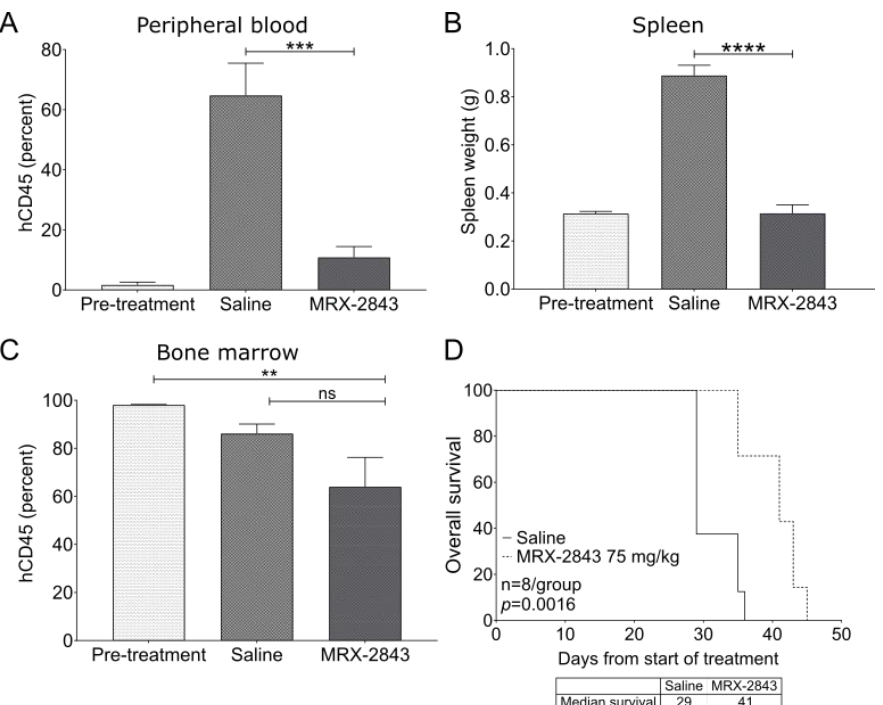
Figure 6. MRX-2843 monotherapy promotes leukemia clearance in peripheral blood and spleen, and prolongs survival in a patient-derived ETP-ALL xenograft model. ( A – D ) NSGS mice were inoculated with xenograft-passaged cells from a patient with ETP-ALL (ETP0068TJ) and treatment was initiated 36 days later. ( A – D ) A cohort of mice were harvested prior to the start of treatment (pre-treatment). The remaining mice were treated once daily with 75 mg/kg MRX-2843 or saline vehicle. ( A – C ) After treatment for 29 days, peripheral blood ( A ), spleen ( B ), and bone marrow ( C ) were collected and leukemic blasts (hCD45+) were detected by flow cytometry. Spleen weight was used as a surrogate for splenic disease burden. Mean values ± SEM are shown (** p ≤ 0.01, *** p ≤ 0.001, **** p ≤ 0.0001, one-way ANOVA, n = 6). ( D ) Survival was monitored in the remaining mice and was significantly prolonged in mice treated with MRX-2843 ( p = 0.0016, log-rank test, n = 8). Abbreviations: ns—not